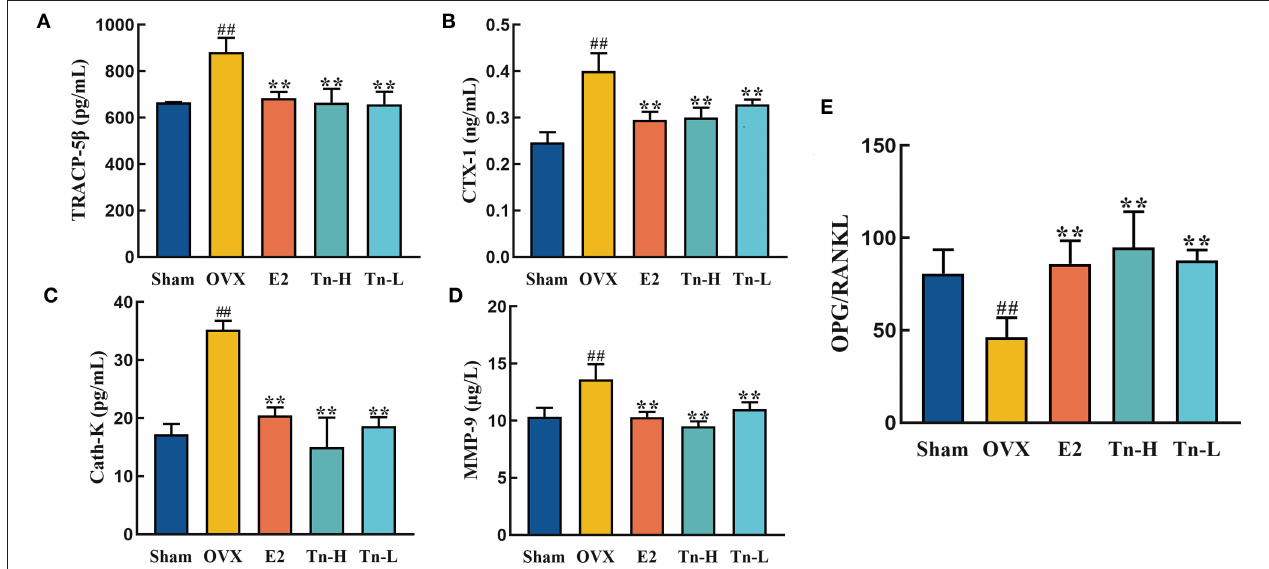
FIGURE 2 | Effect of THLs on bone resorption-related indexes in serum of rats. Bone resorption-related indexes including TRACP-5 β (A) , CTX-1 (B) , Cath-K (C) , and MMP-9 (D) . (E) The ratio of OPG to RANKL at serum level (Tn-H, high-dose THLs group; Tn-L, low-dose THLs group). Data are presented as the mean ± SD ( n = 8 per group). Multiple comparisons were performed using one-way ANOVA. # p < 0.05 vs. Sham group; ## p < 0.01 vs. Sham group; * p < 0.05 vs. OVX group; ** p < 0.01 vs. OVX